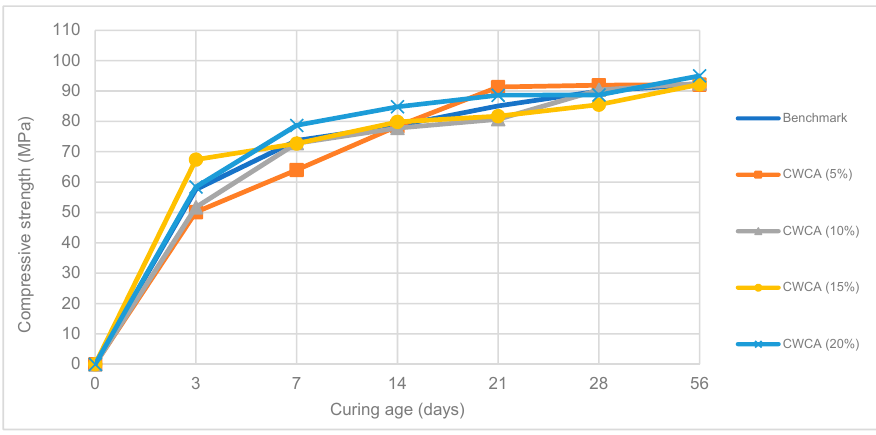
Figure 7. Compressive strength variation of samples containing various doses of CWCA.